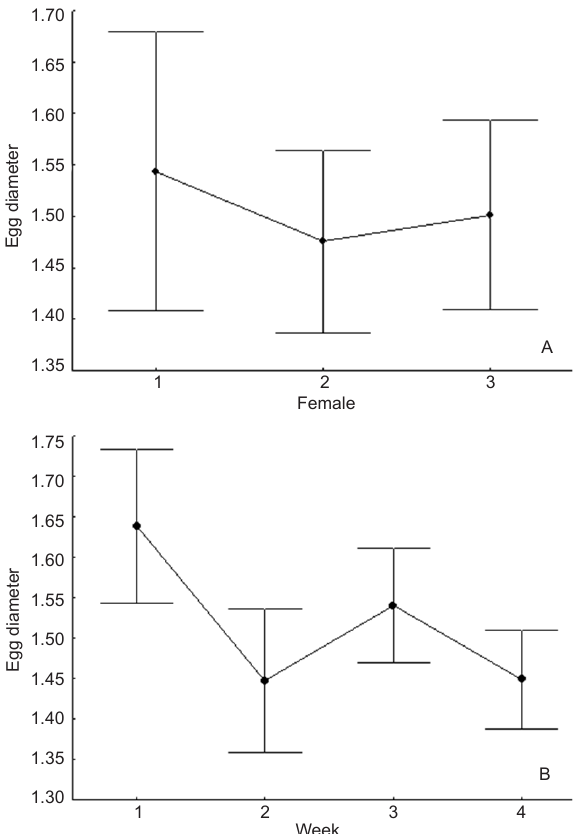
Figure 2. Mean of egg diameter (±SD) of each female of Austrolebias nigrofasciatus in natural environment (A) and of weekly mean of egg diameter (B) during four